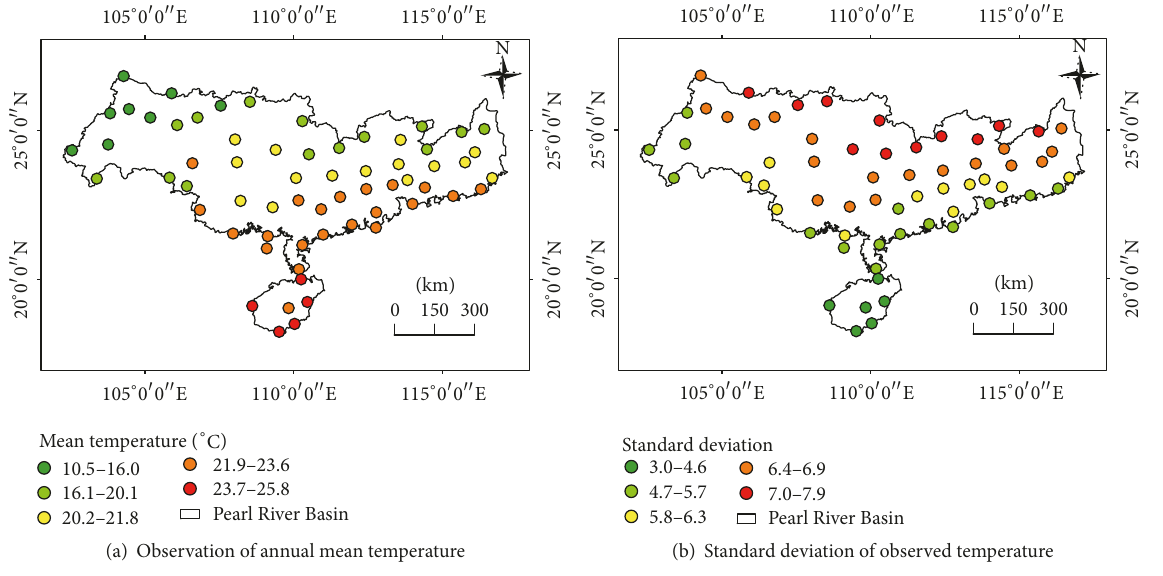
Figure 2: Observed mean temperature and standard deviation at the meteorological stations.